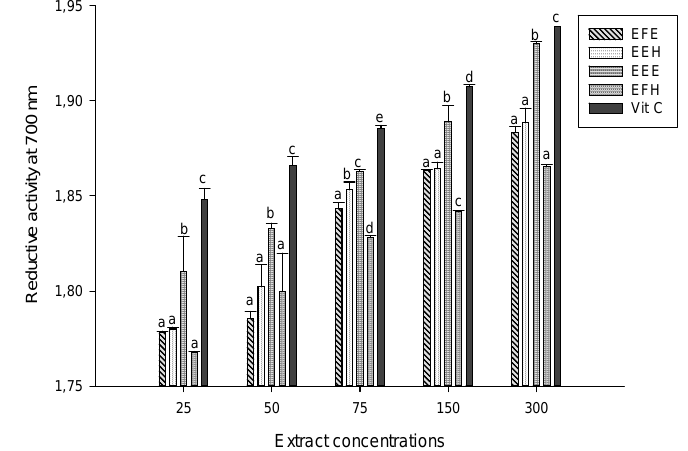
mean ± SD of three replicates. In the same concentration the values labeled with different letters differ significantly at p < 0.05. EEE: H. zenkeri ( bark) ethanolic extract; EFE: H. zenkeri (leaves) ethanolic extract; EEH: H. zenkeri (bark) hydro-ethanolic extract;